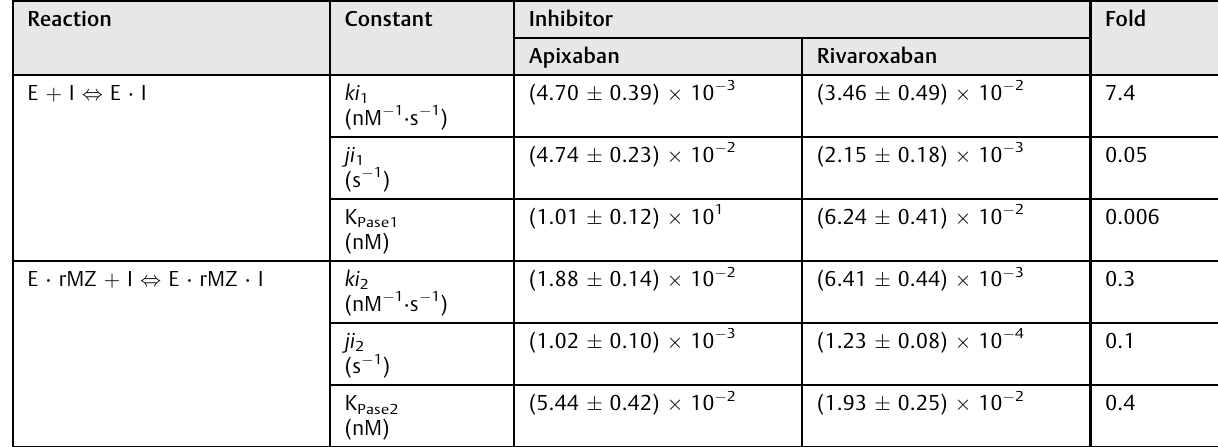
Table 3 Kinetic parameters of factor Xa inhibition by apixaban or rivaroxaban as measured using meizothrombin-DAPA fl uorescence Reaction